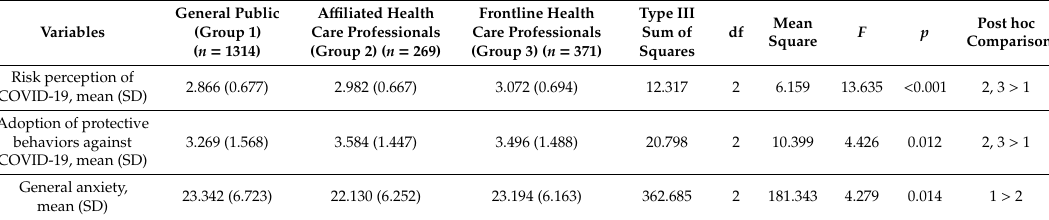
Table 3. Comparisons of Risk Perception, Adoption of Protective Behaviors, and General Anxiety Among the General Public and A ffi liated and Frontline Health Care Professionals: Multivariate Analysis of Variance.